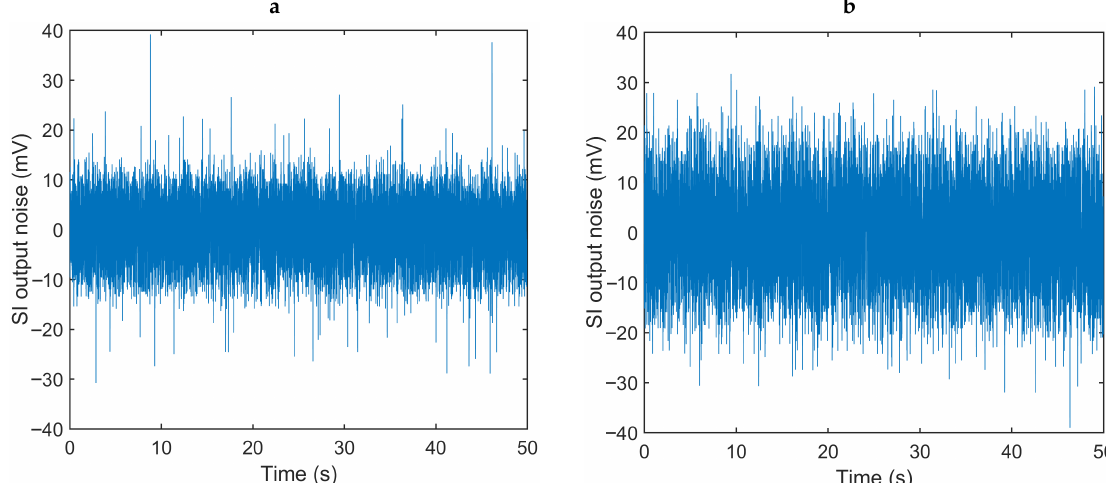
Figure 8. Noise at the output of the switched integrator for ( a ) a photocurrent of 3 µA, and ( b ) a photocurrent of 10 µA, showing the effect of the PD shot noise.